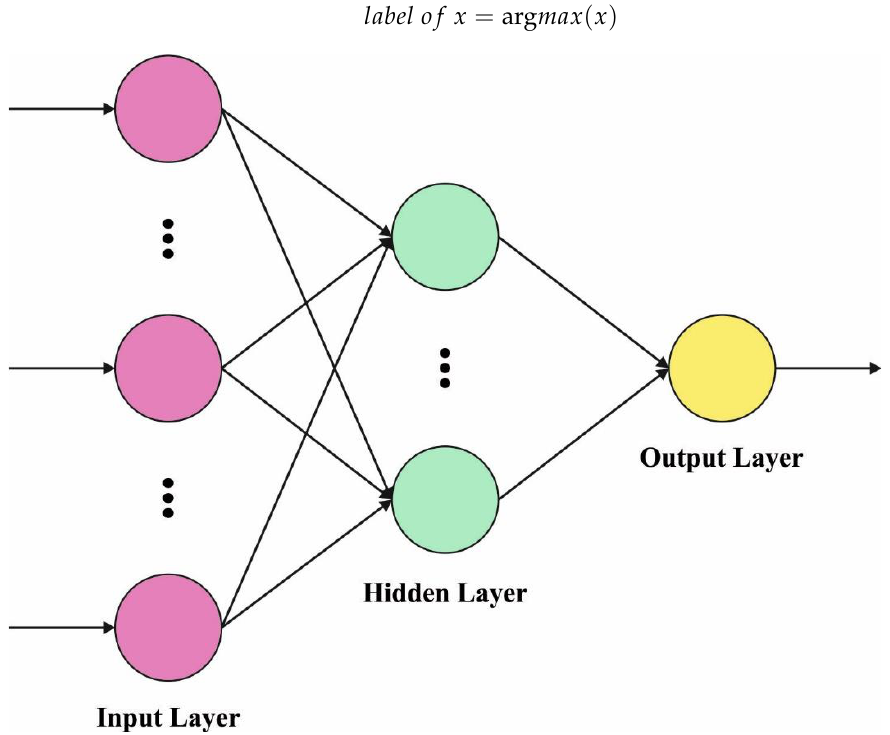
Figure 3. Structure of Weighted ELM.